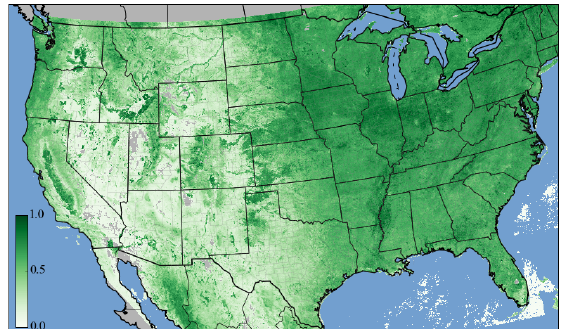
Figure 6: MODIS EVI smoothed by the wavelet transform